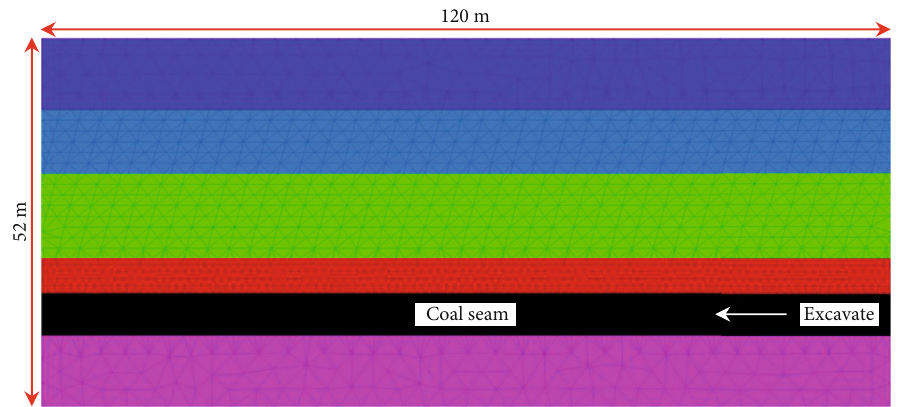
Figure 11: Numerical